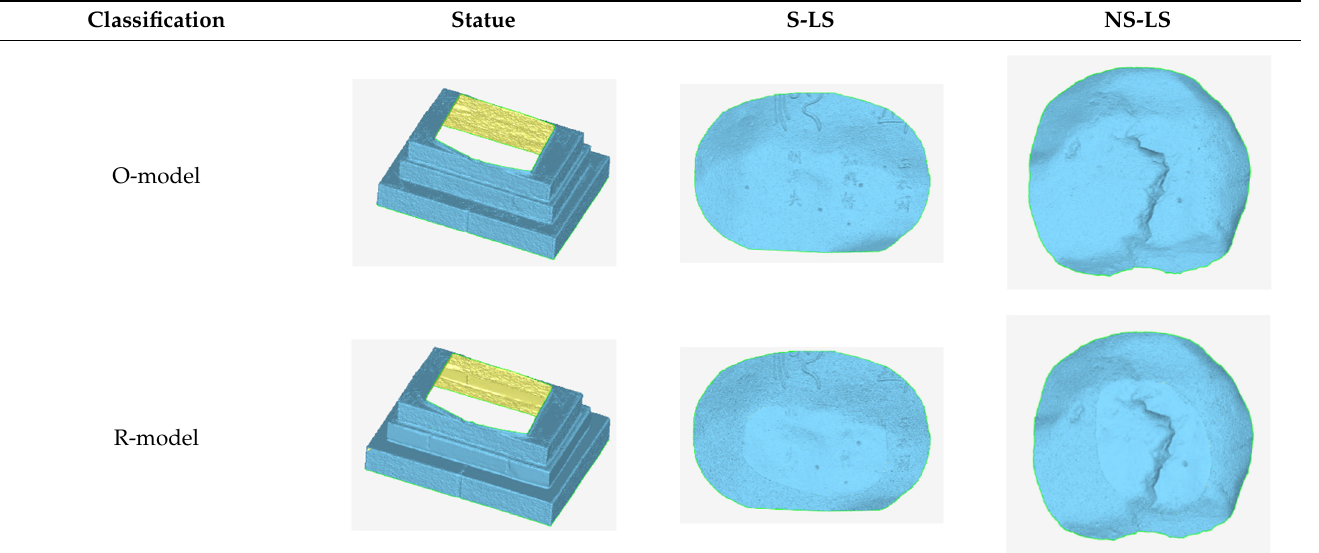
Table 13. Comparison of O-model and R-model.